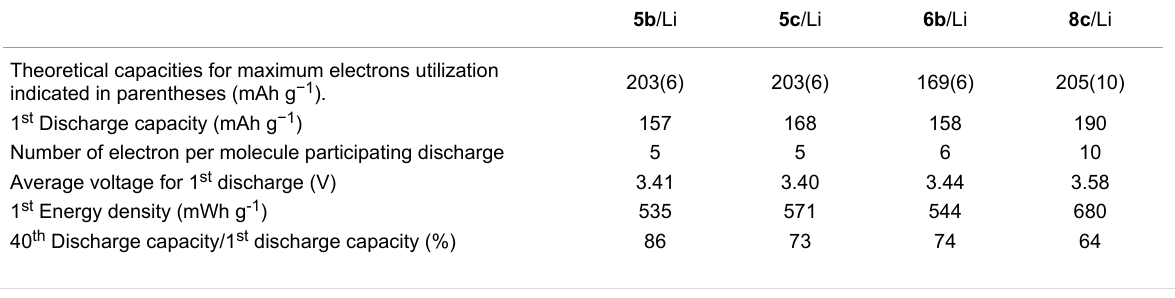
5b /Li 5c /Li 6b /Li 8c /Li